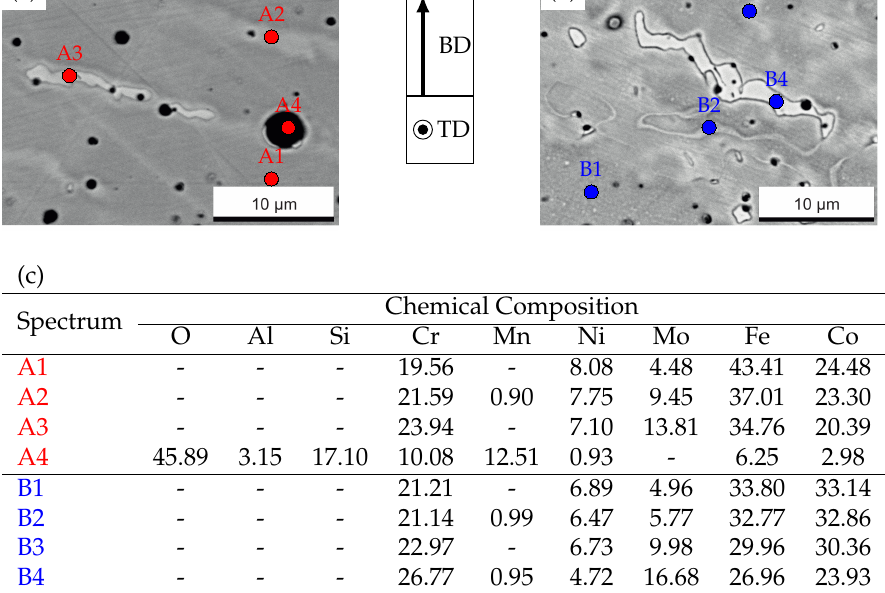
Figure 6. SEM-images of ( a ) sharp; ( b ) smooth transition zones of AISI316L and CoCrMo, with markers indicating locations of EDS-spectra measurements; ( c ) chemical composition based on obtained EDS-spectra, in